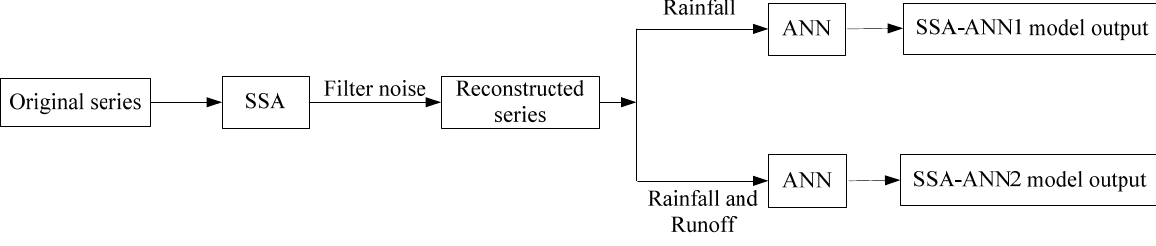
Figure 2. Schematic diagram of SSA-ANN